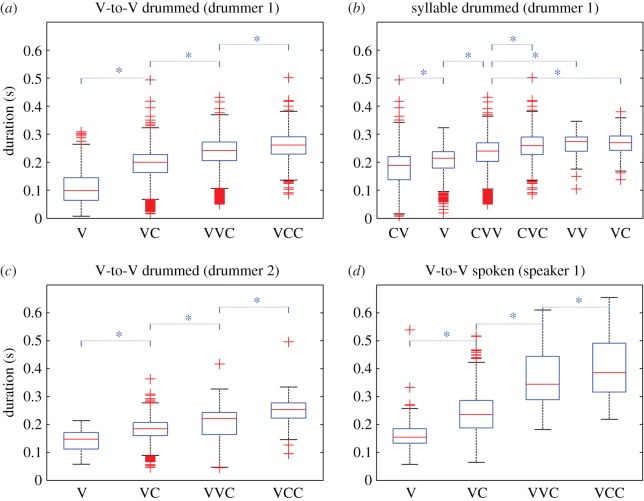
Distribution of drummed IBDs as a function of V-to-V types (a) and syllable types (b) for the first drummer, drummed IBDs as a function of V-to-V types for the second drummer (c) and durations of spoken V-to-V types (d) (VV, long vowel; CC, hC or ʔC). Further results are provided in electronic supplementary material, S1.